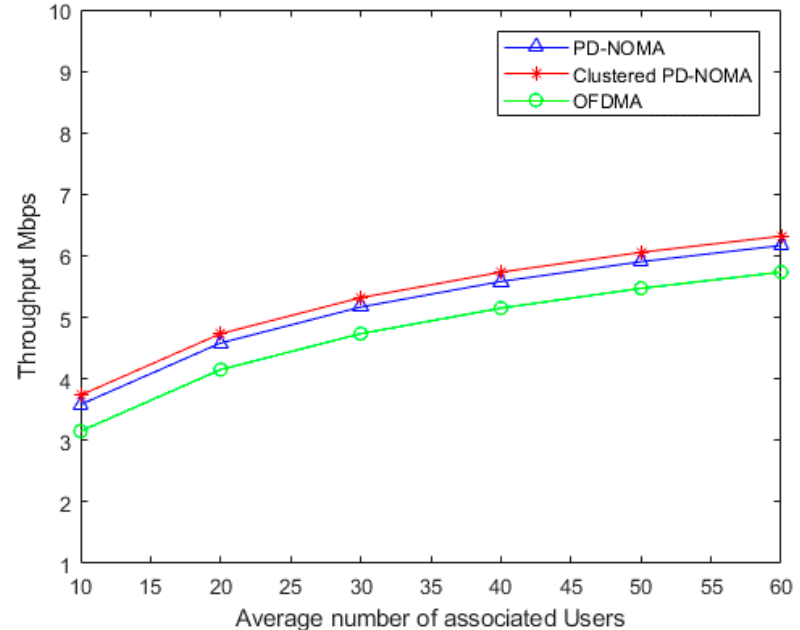
Figure 7. Number of associated users with the SBS versus the maximum throughput achieved .